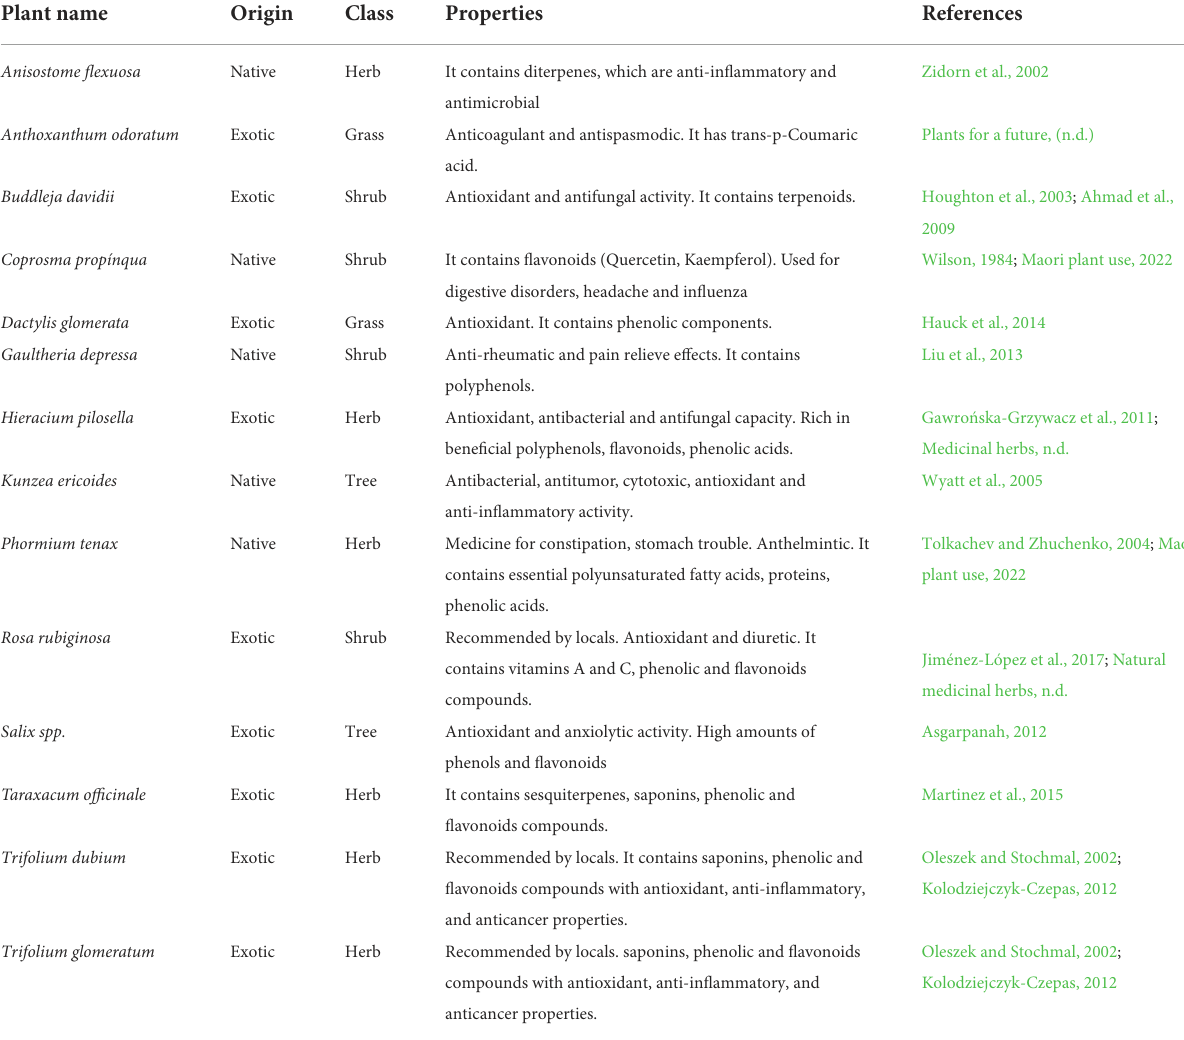
TABLE 1 Characteristics and properties of plant species selected for chemical analysis to illustrate a methodology to create healthscape maps, using the Lincoln University Mount Grand Station (LUMGS) high-country station as a case